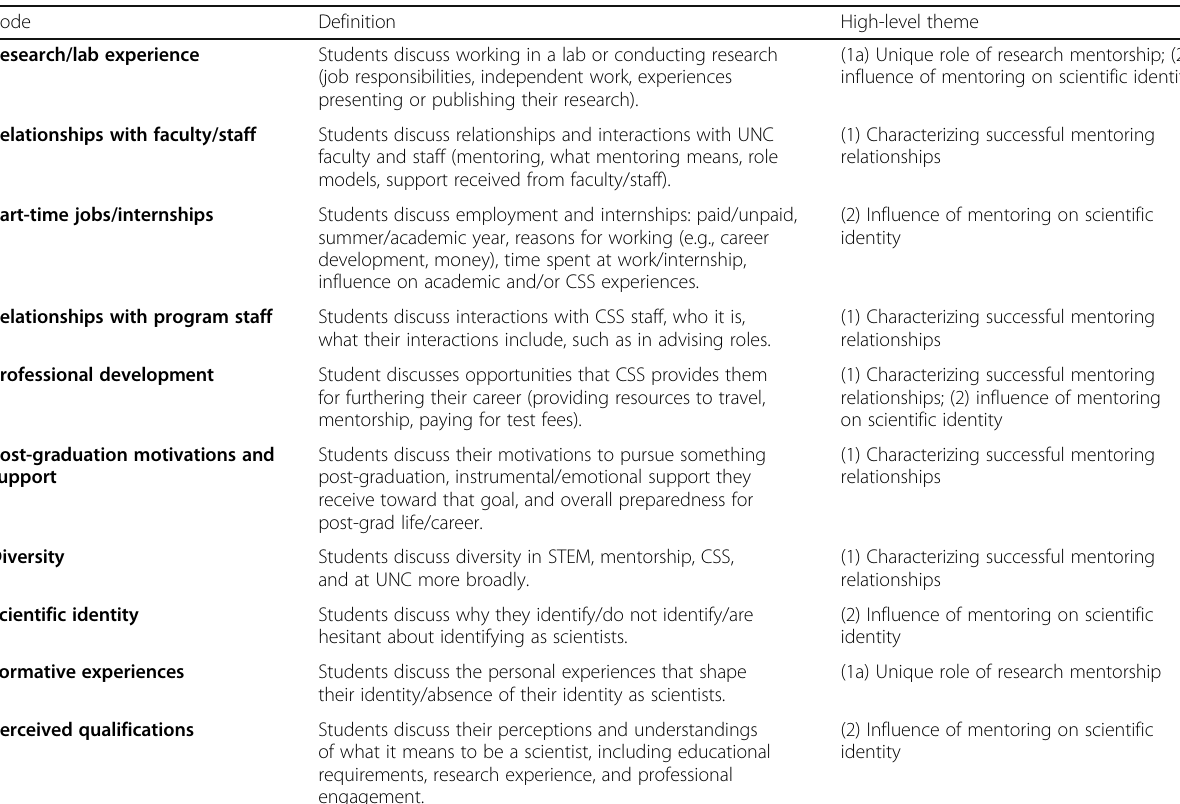
Table 1 Summary of relevant codes and corresponding